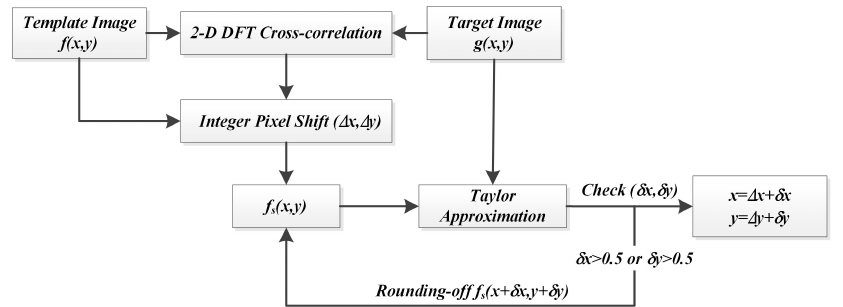
Figure 4. Flowchart of refinement using Taylor approximation with the reformative iteration operation.